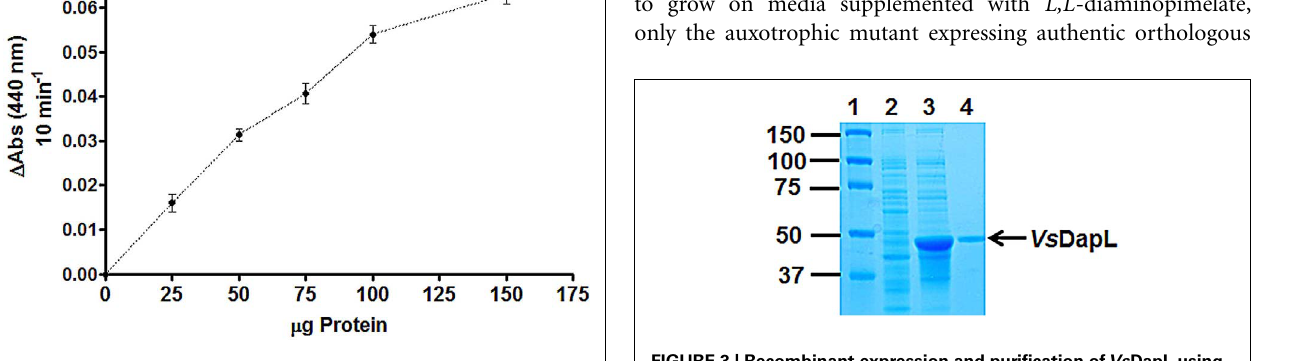
FIGURE 2 | DapL activity from crude protein extract from V. spinosum . The graph shows the relationship between the protein amount and reaction rate.The DapL ortho -aminobenzaldehyde assay is described in the Section “Materials and Methods.”The assay was done in triplicates for each protein concentration.